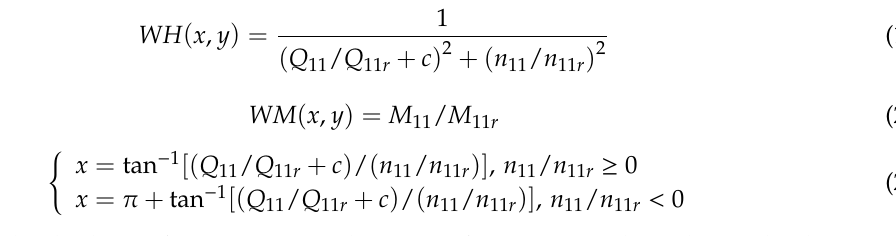
Table 1. Parameters of water conveyance system.